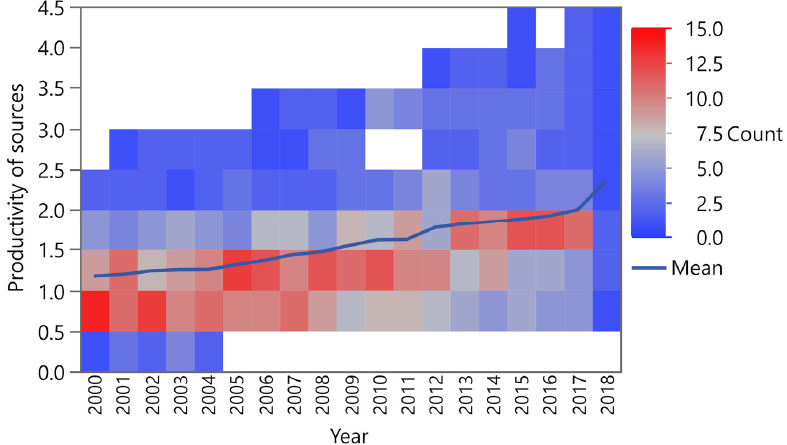
Figure 2. Average resources policy in EU in 2000–2018.